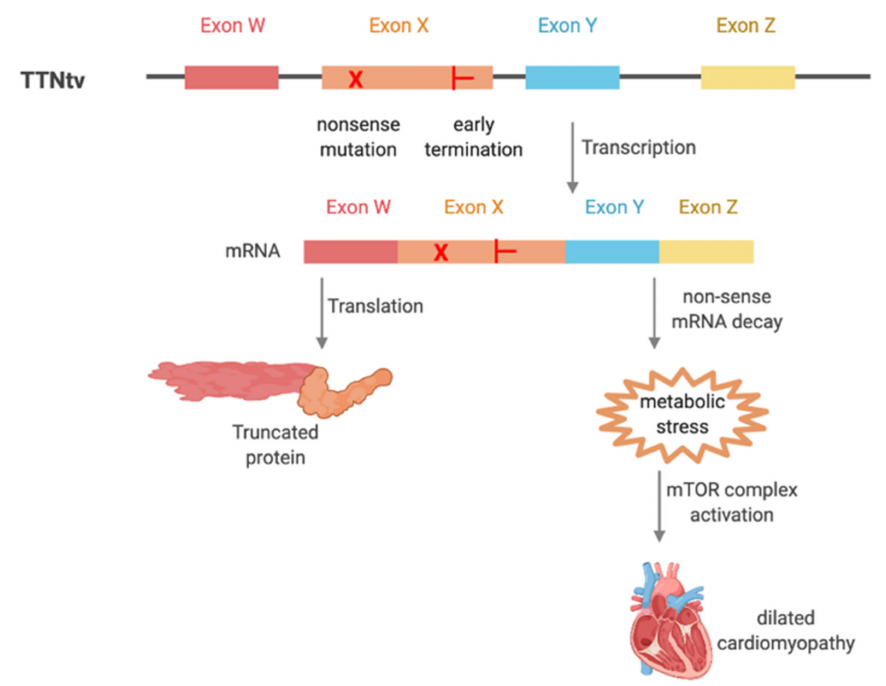
Figure 3. Titin truncation variations (TTNtv) lead to dilated cardiomyopathy related to haploinsufficiency and increased metabolic stress. TTNtv is likely to lead to dilated cardiomyopathy phenotype due to increased non-sense mRNA decay leading to increased metabolic stress and activation of the mammalian target of rapamycin (mTOR) complex signaling pathway. mTOR complex activation is associated with development of dilated cardiomyopathy as a downstream signaling